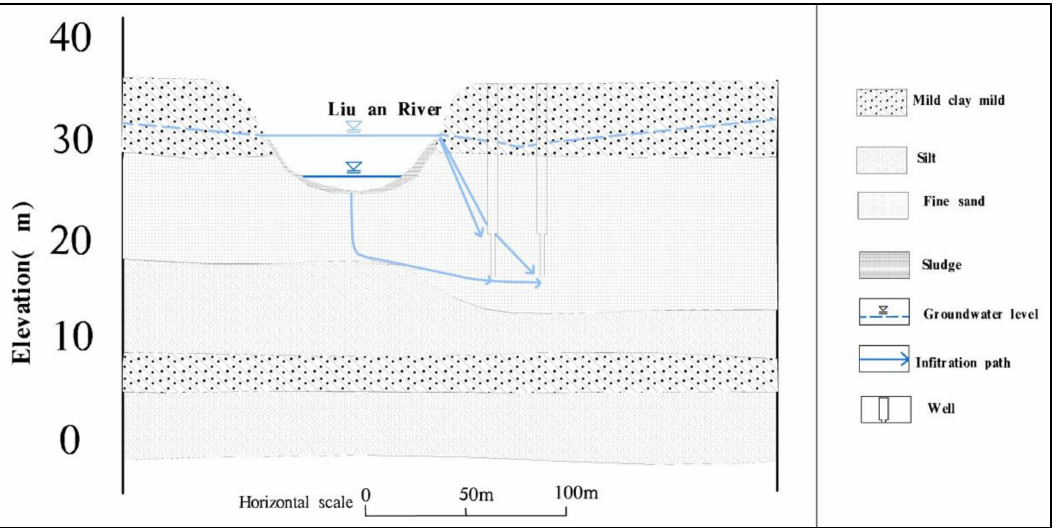
Figure 10. Flow direction of the groundwater under pumping conditions in a 95% typical dry year.